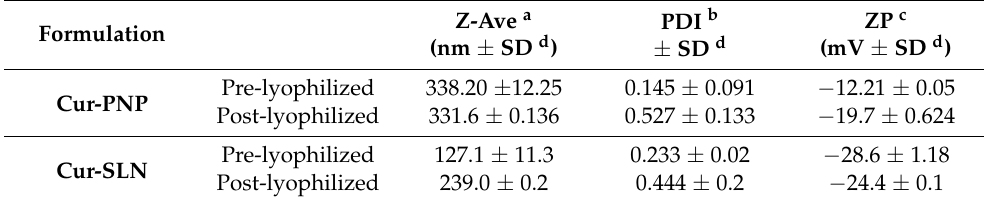
Table 2. Z-Ave, PDI, and ZP values of Cur-PNP and Cur-SLN before and after the freeze-drying pro- cess.